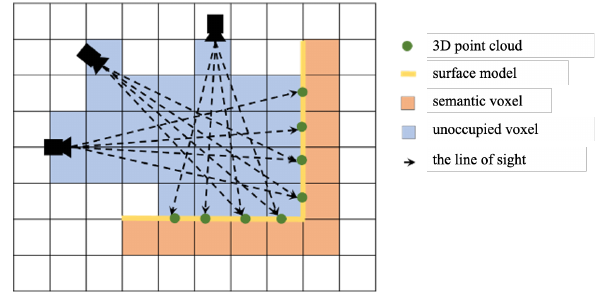
Figure 6. Two-dimensional diagram of voxel